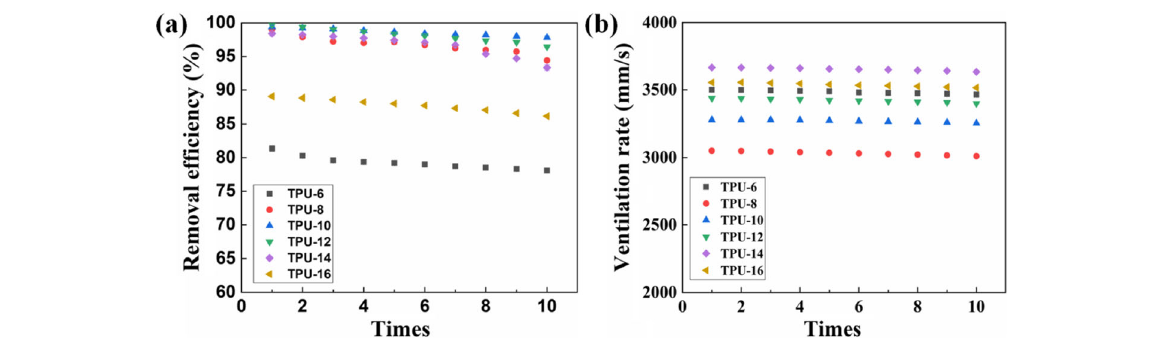
Fig. 8 Reproducibility of the ventilation rate and removal efficiency of the composite fiber membrane. a Reproducibility of the removal efficiency. b Reproducibility of the ventilation